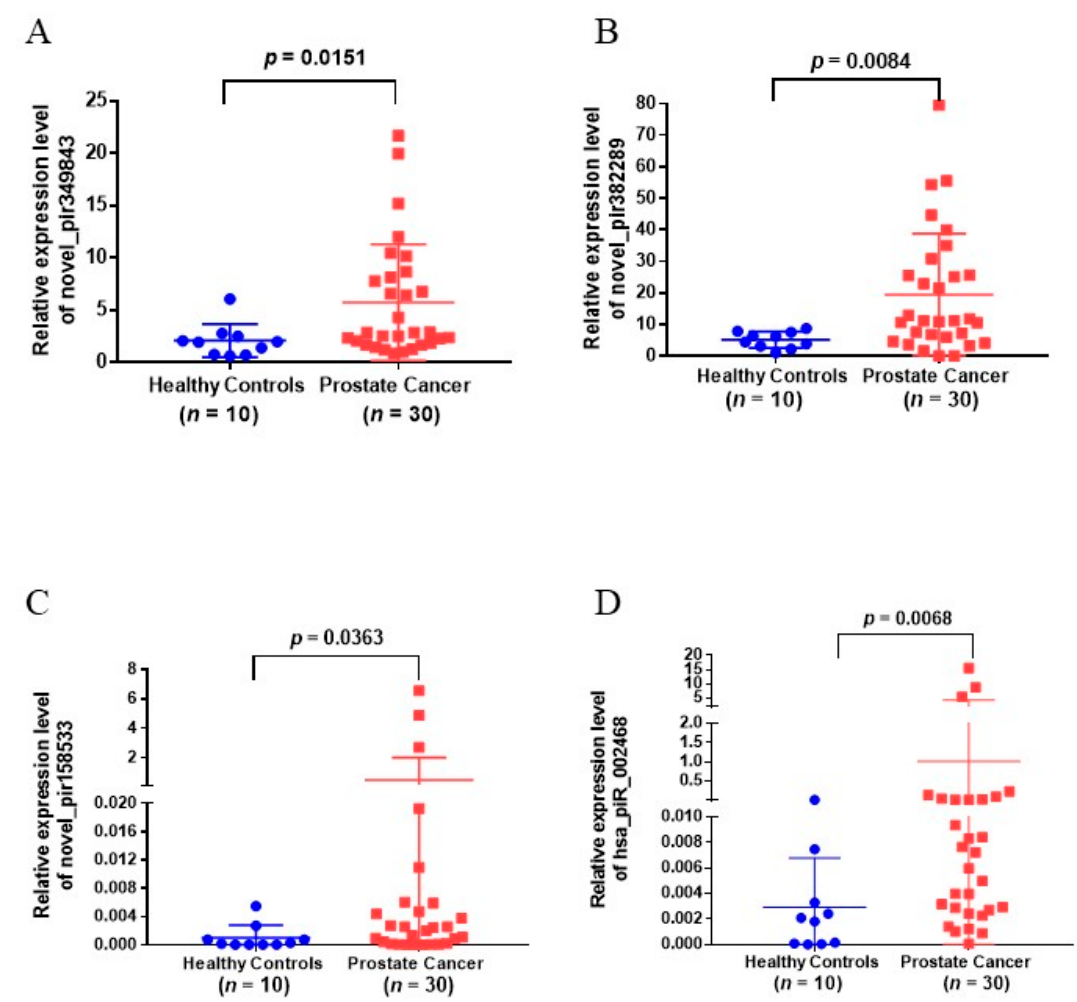
Figure 2. Upregulated piRNAs in validation cohorts. ( A – D ) Relative piRNA expression levels of ( A ) novel_pir349843, ( B ) novel_pir382289, ( C ) novel_pir158533, and ( D ) hsa_piR_002468 were examined in urinary EVs of PCa patients ( n = 30) and healthy controls ( n = 10) using TaqMan real-time PCR Assays.